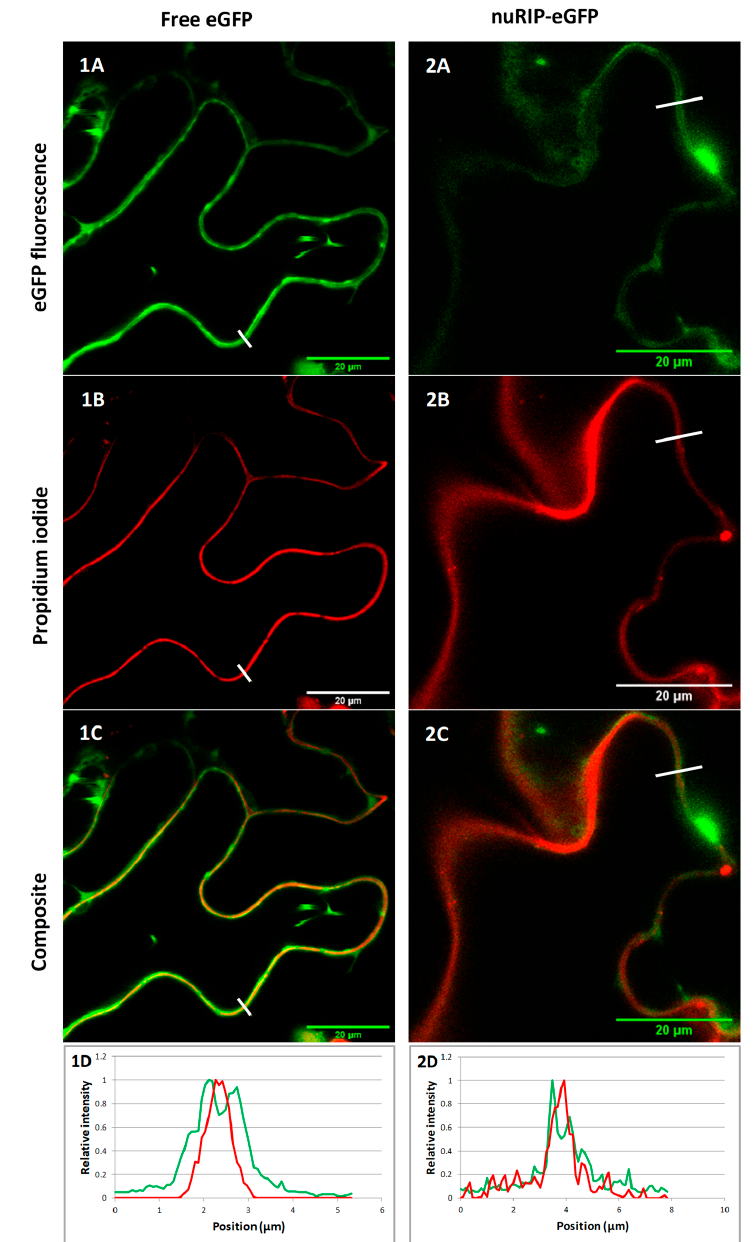
x-axis represents the distance along the white line.